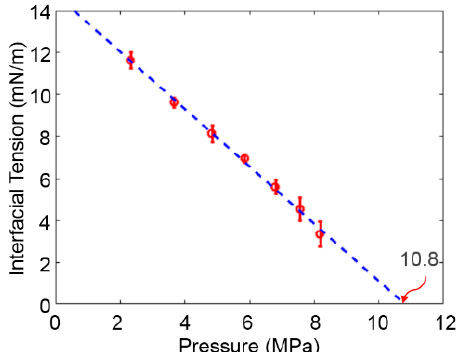
Figure 3. Interfacial tensions of CO 2 and n -octane binary system as a function of the pressure at 343.15 K. Red circles are the simulation results. The blue dash line comes from the linear fitting: IFT = − 1.369P + 14.786.